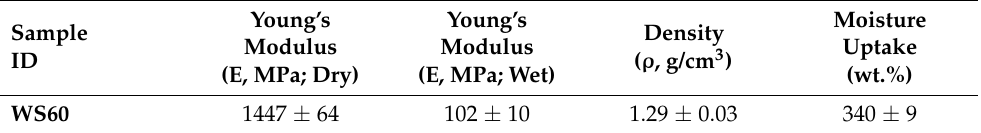
Table 2. Mechanical and physicochemical properties of the WS60 biocomposite